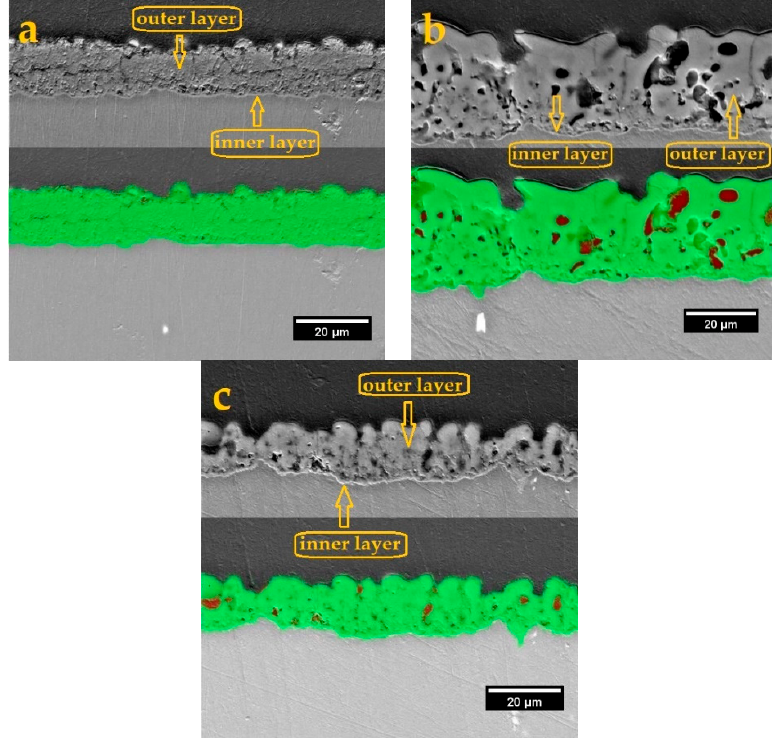
Figure 3. The cross-sectional morphology of PEO coatings prepared at different electrolytes: ( a ) Al, ( b ) Ph, and ( c ) Si.